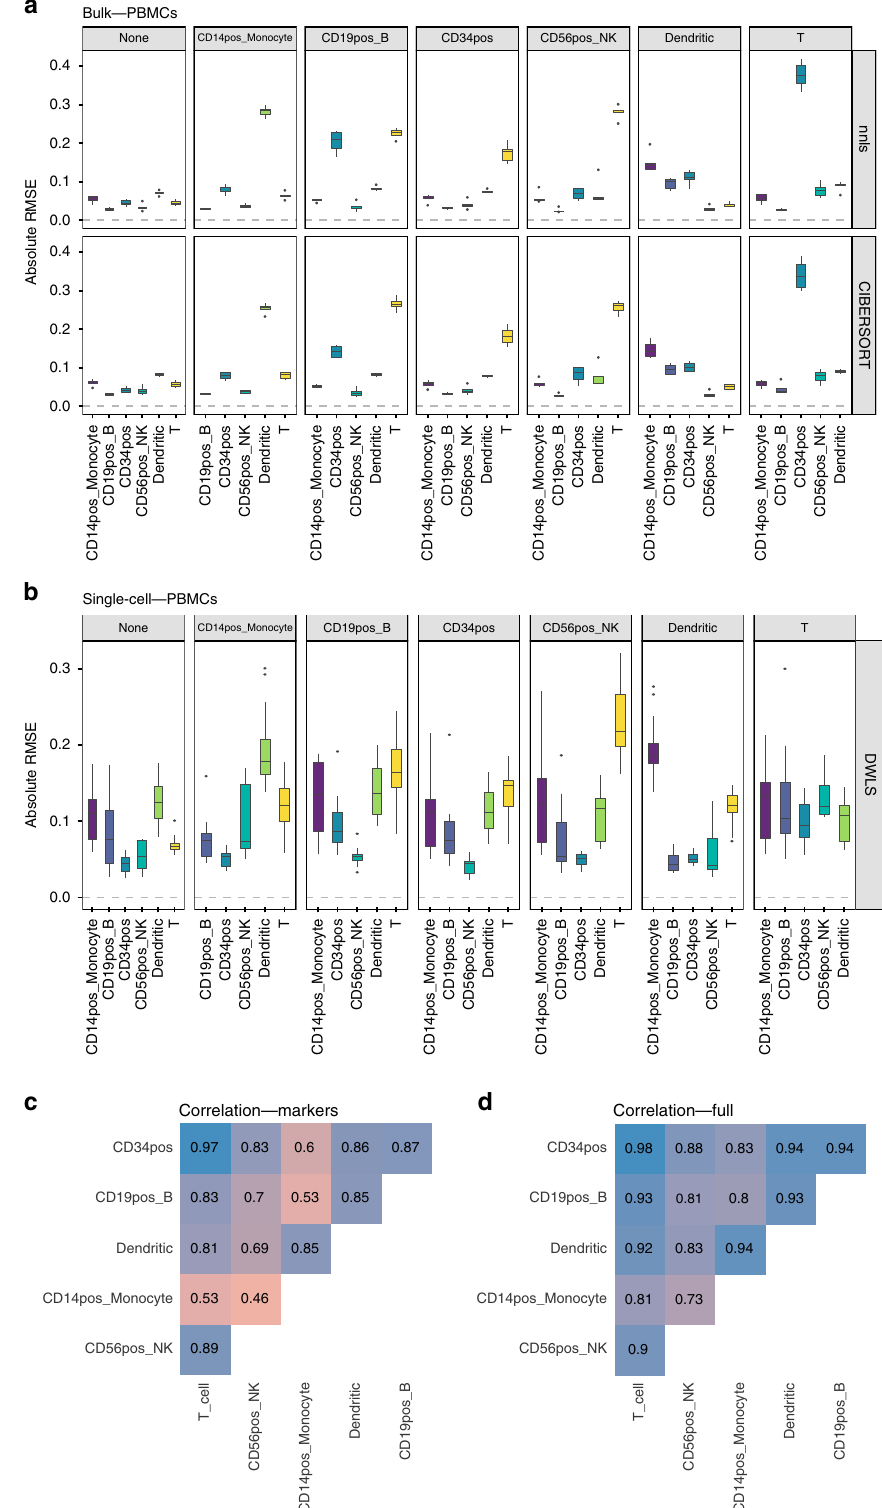
Fig. 5 Effect of cell type removal on the deconvolution results for the PBMCs dataset (100-cell mixtures; linear scale). a Results using bulk deconvolution methods (nnls and CIBERSORT); b results with deconvolution methods using scRNA-seq data as reference (only DWLS because the data comes from only one individual). c Pairwise Pearson correlation values between expression pro fi les for the different cell types, using a subset of the reference matrix containing only the markers used in the bulk deconvolution; d pairwise Pearson correlation values between complete expression pro fi les for the different cell types. In a , b , each gray column represents a speci fi c cell type removed. Each data point conforming a boxplot represents a different scaling/normalization strategy